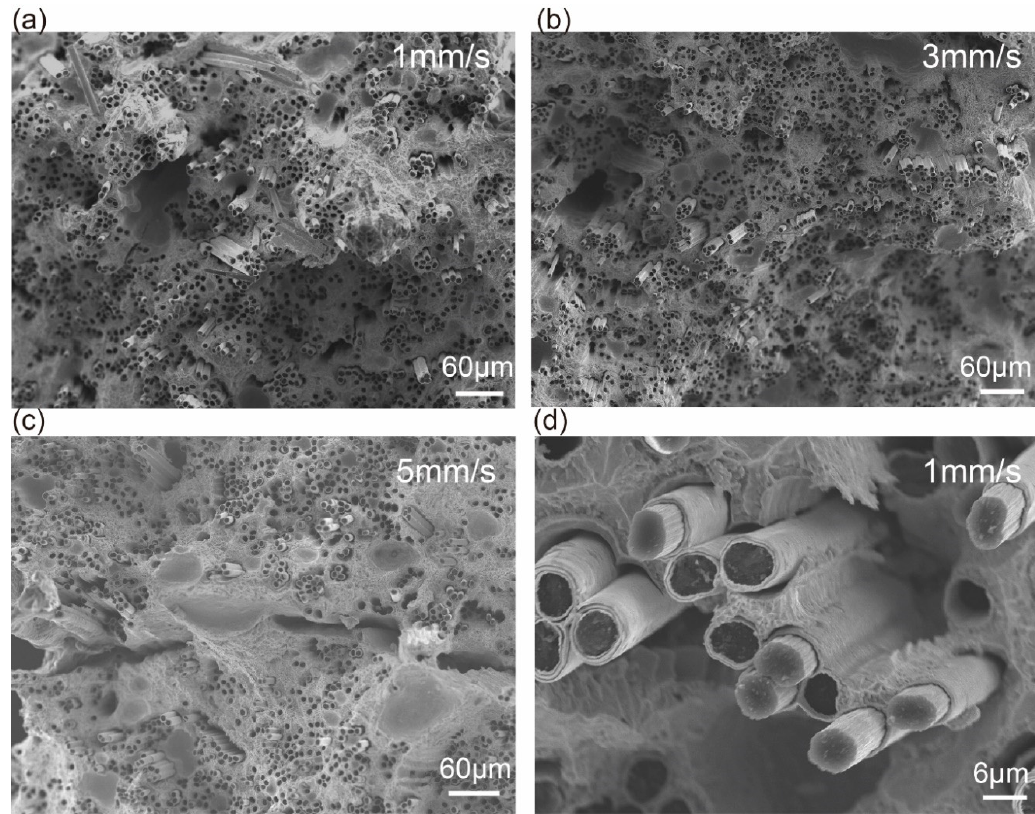
Figure 4. Morphologies of fracture surface for composite specimens ( a ) S1, ( b ) S3, and ( c ) S5; ( d ) Image of S1 specimen observed with higher magnification SEM.